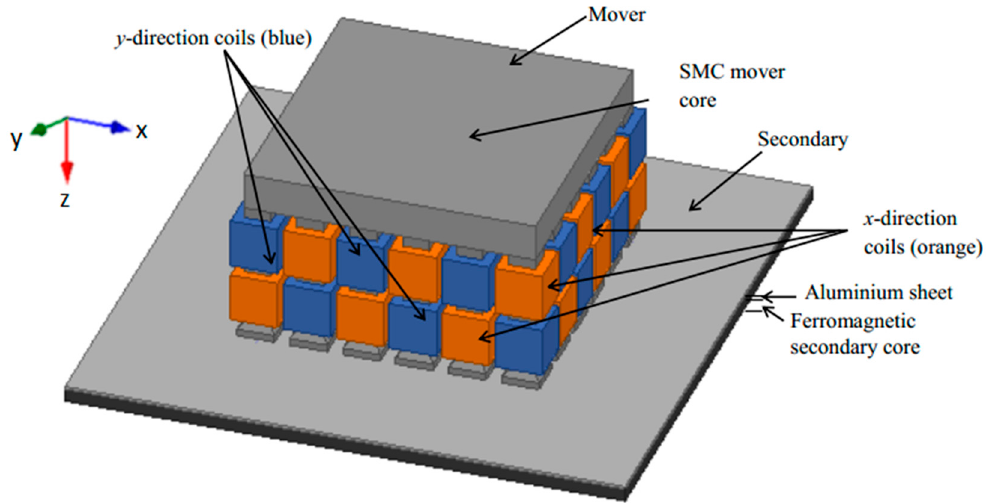
Figure 1. Double-layered planar actuator topology [11]. © 2015 IEEE. Reprinted, with permission, from IEEE Transactions on Magnetics.